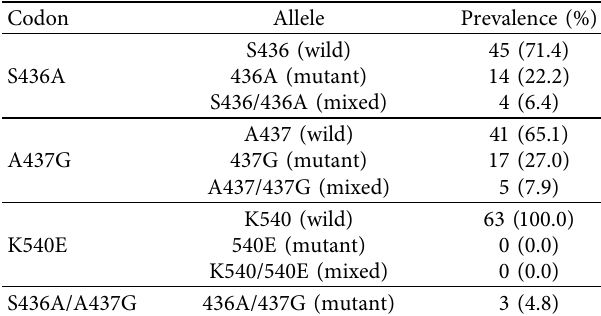
Table 2: Single nucleotide polymorphisms of Pfdhps codons S436A, A437G, and